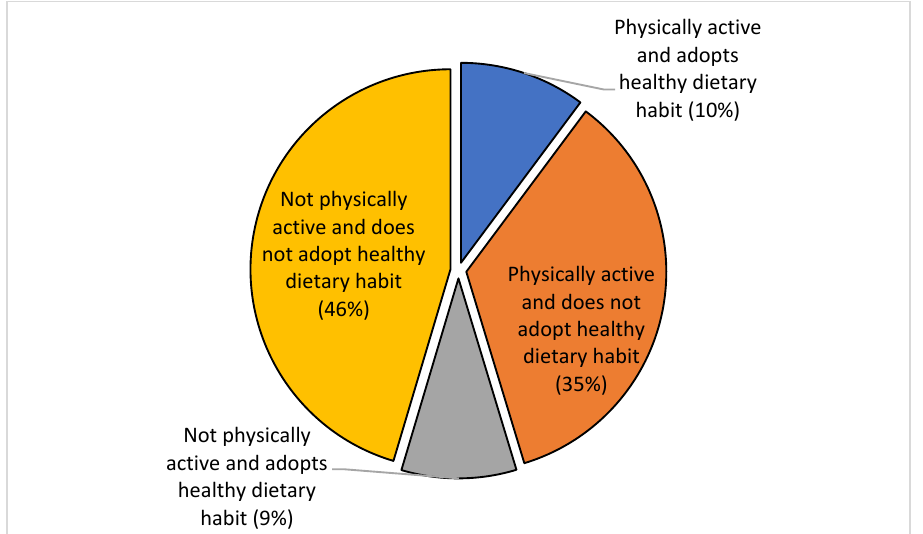
Figure 1. Participation in physical activity and adoption of healthy dietary habits.